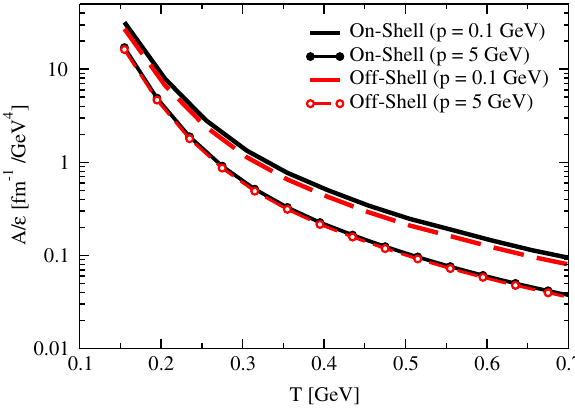
Fig. 2 Drag coefficient ( A ( T ) ) as a function of the medium tempera- ture at fixed HQ momentum p = 0 . 1 GeV for on-shell approach (black solid line) and off-shell approach (red dashed line)